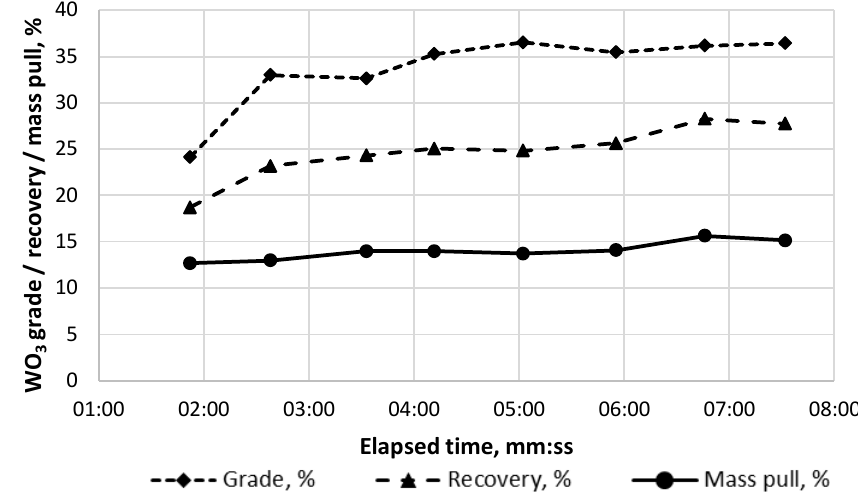
Figure 11. Results of experiments to monitor variation in concentrate grade, recovery and mass pull to concentrate outlet over time.